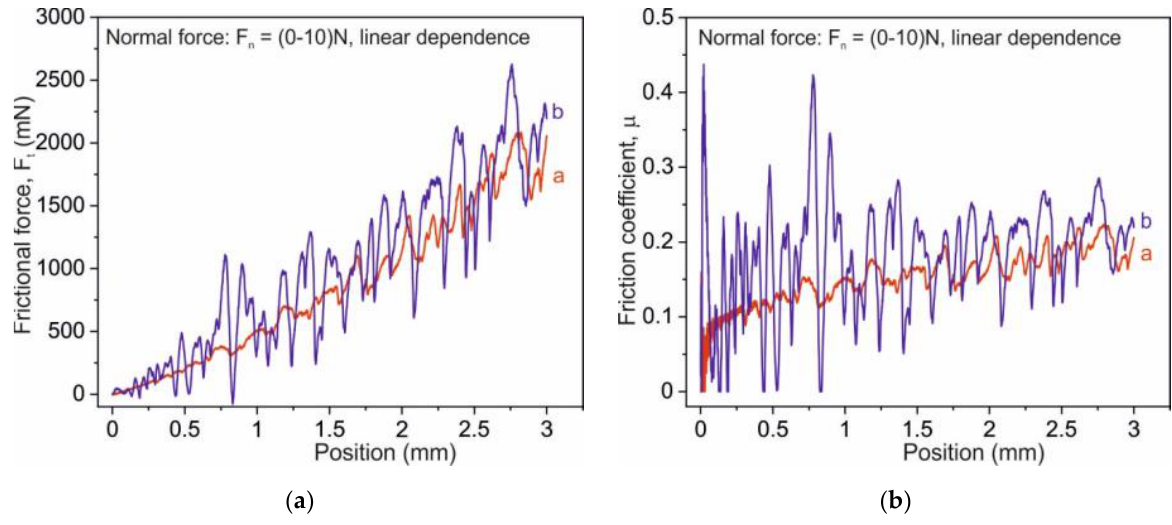
Figure 11. Frictional force displacement curves for scratch tests (left side) and friction coefficient displacement curves for polished (curve a , red color) and cut (curve b , blue color) Co-Cr discs.